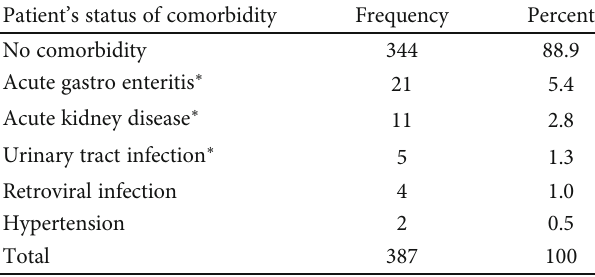
Table 3: Patient ’ s status of comorbidity with severe malaria in Arba = 387